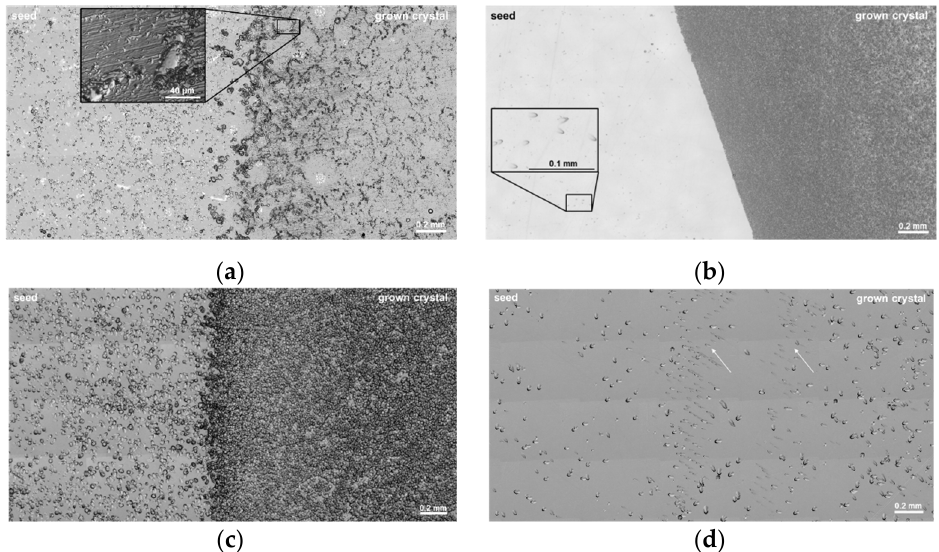
Figure 2. Microscopic images of KOH-etched wafers depicting the transitional layer between seed and grown crystal of ( a ) crystal A, ( b ) crystal B, ( c ) crystal C, and ( d ) crystal D.